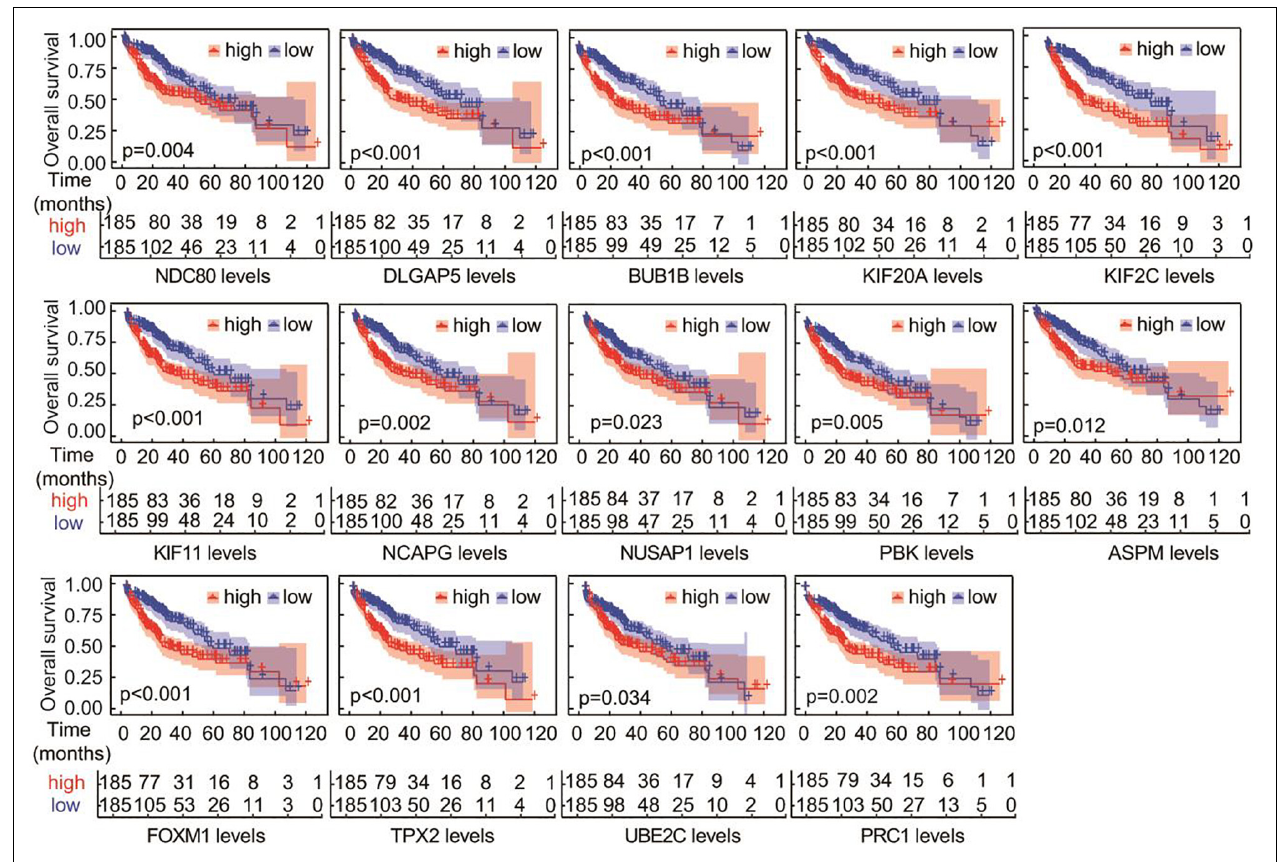
FIGURE 5 | Overall survival analyses of the overlapping hub genes. Analysis was performed using the survival and survminer packages in R. P -values were used to indicate significant